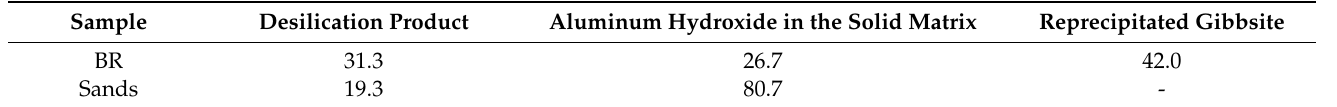
Table 3. The results of the semiquantitative calculation of the aluminum-containing phase composition in the BR and sands, wt.%.